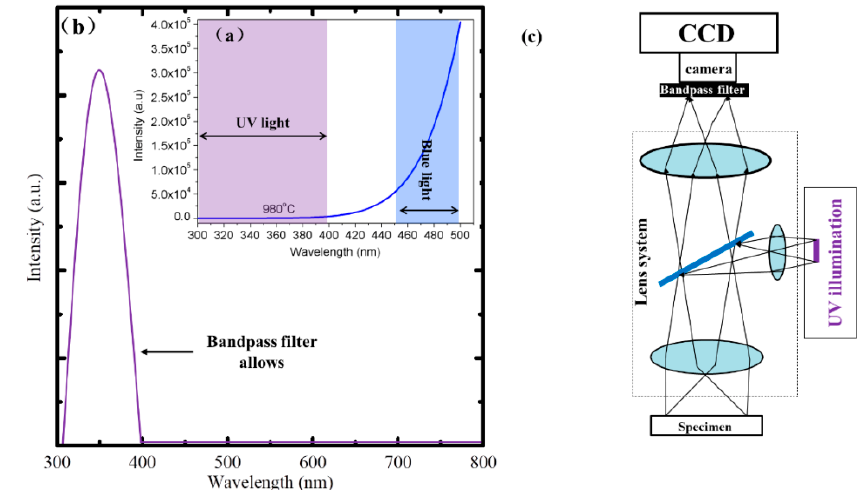
Figure 1. ( a ) Intensity and wavelength relationship at 980 °C according to Planck’s radiation law; ( b ) the transmittance property of ultra violet (UV) bandpass filter; ( c ) schematic illustration of the structure of the UV optical system [18].